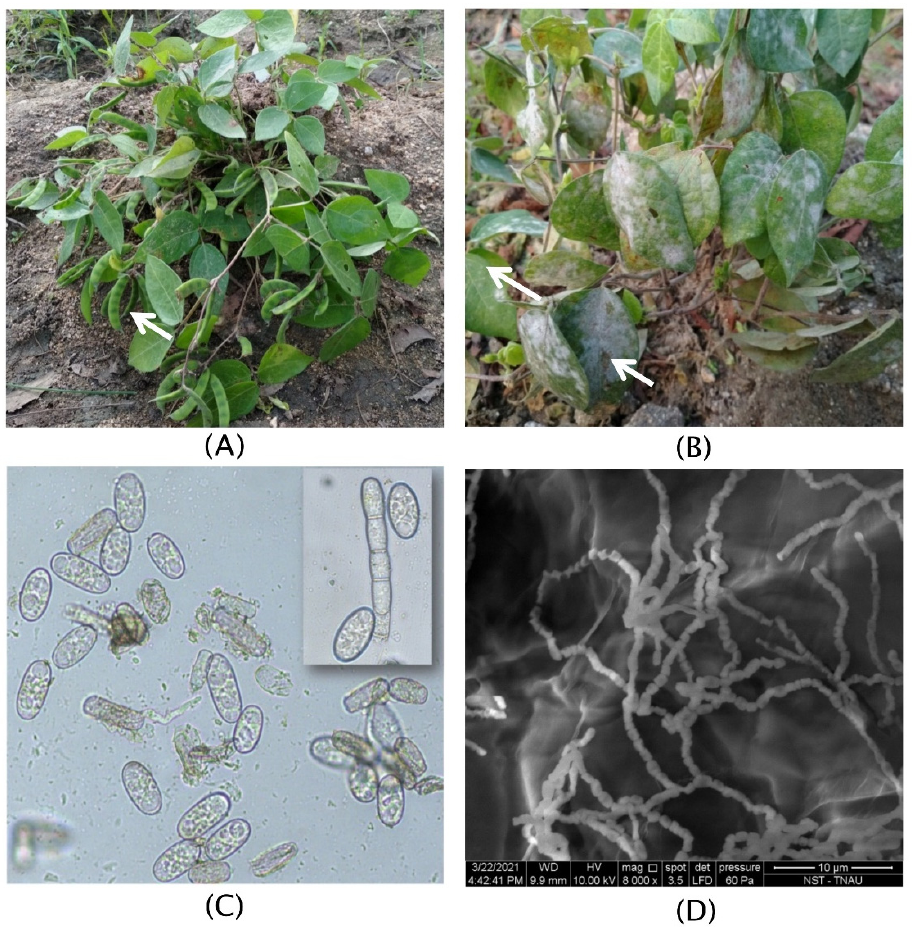
Figure 1. ( A ) Powdery mildew-resistant mutant; ( B ) powdery mildew-susceptible mutant. ( C ) Identification of the powdery mildew species: phase-contrast microscopy. ( D ) Identification of powdery mildew species: SEM.